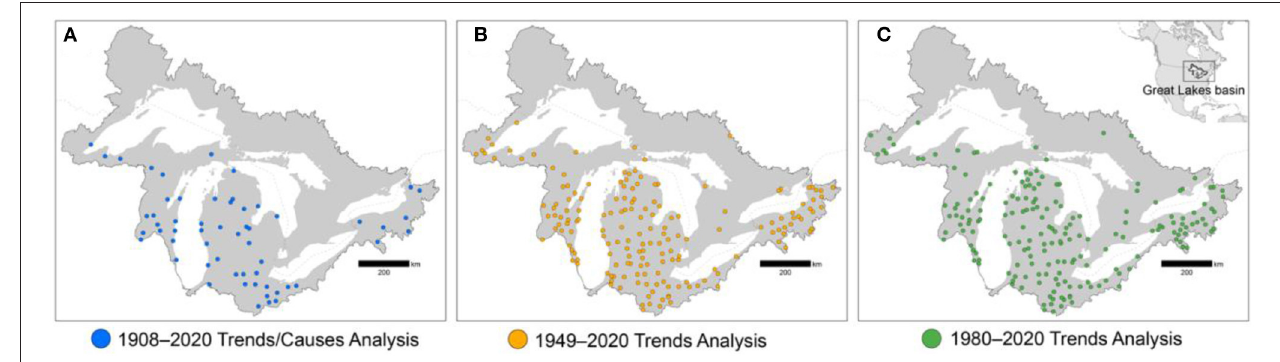
FIGURE 1 | Locations of the stations used in (A) the trends and causes analysis for 1908–2020, (B) the trends analysis for 1949–2020, and (C) the trends analysis for 1980–2020. The white area indicates water bodies and the dark gray area indicates land area within the Great Lakes drainage